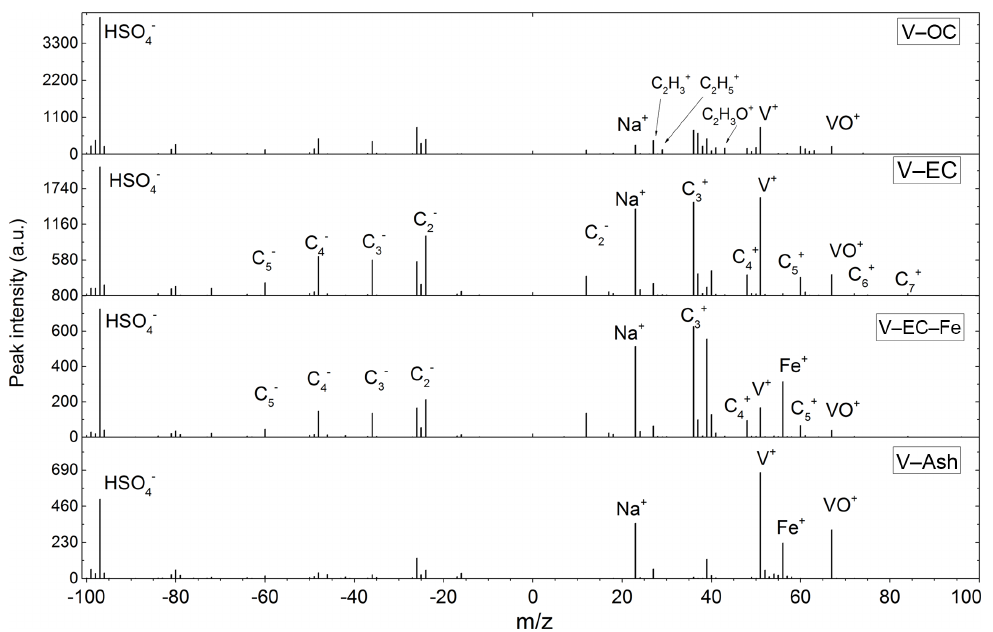
Figure 6. Mean mass spectra of four major particle types from fresh ship emissions.